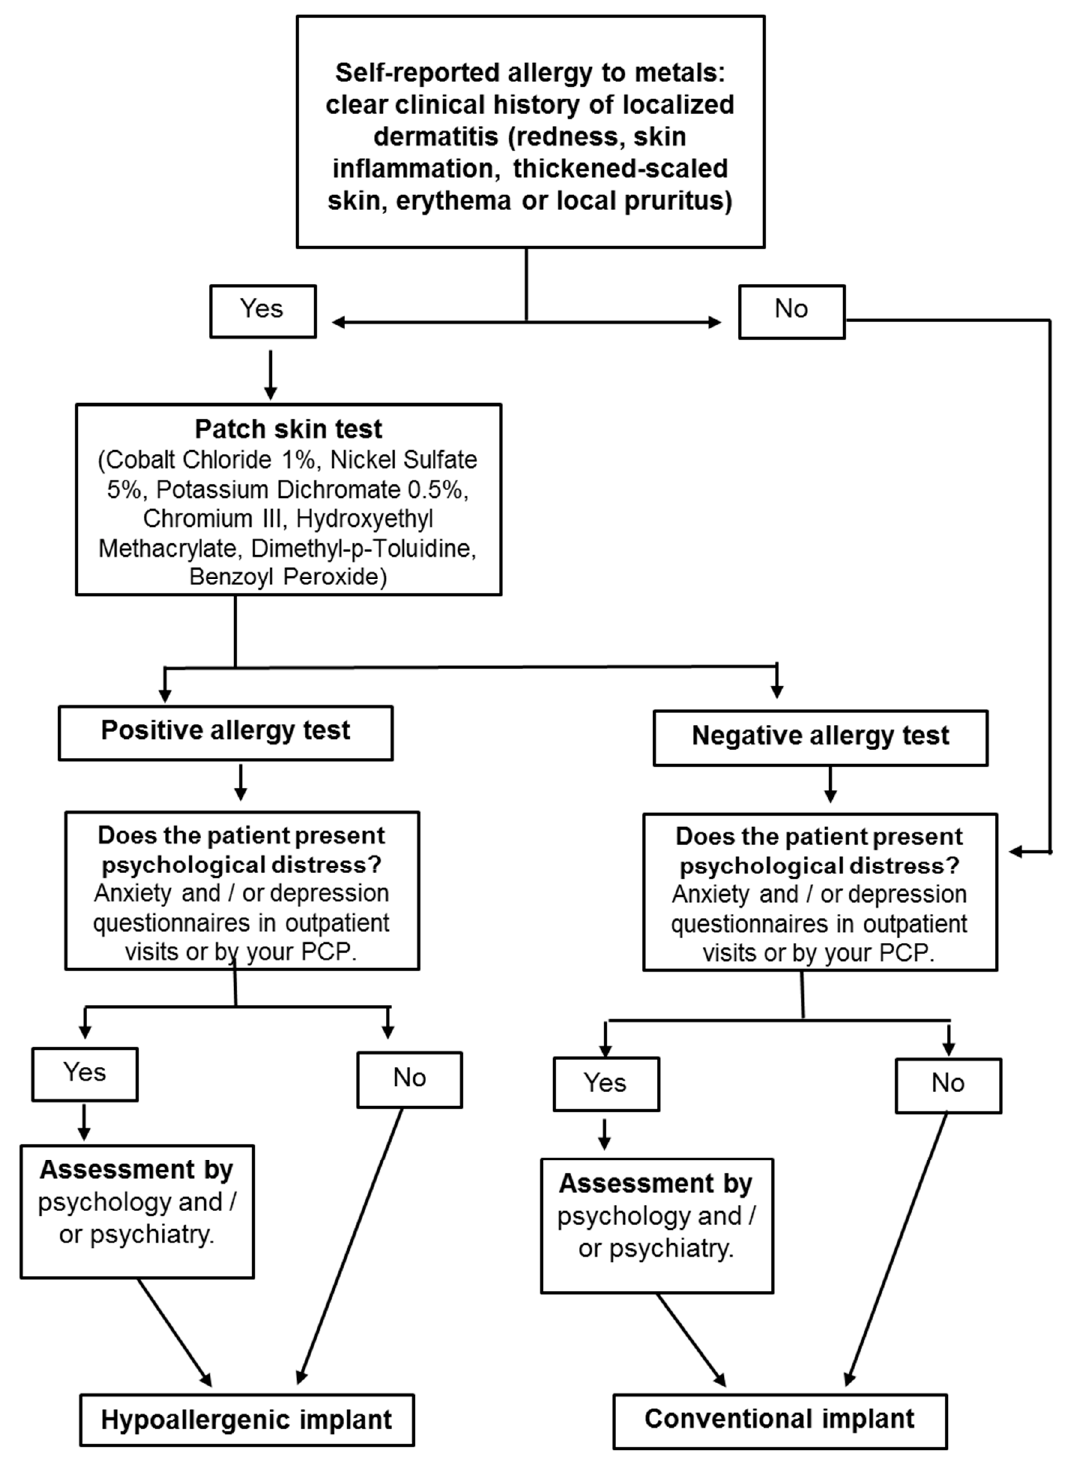
Figure 2. Algorithm for the diagnosis and treatment of metal allergy in a patient with knee osteoarthritis.